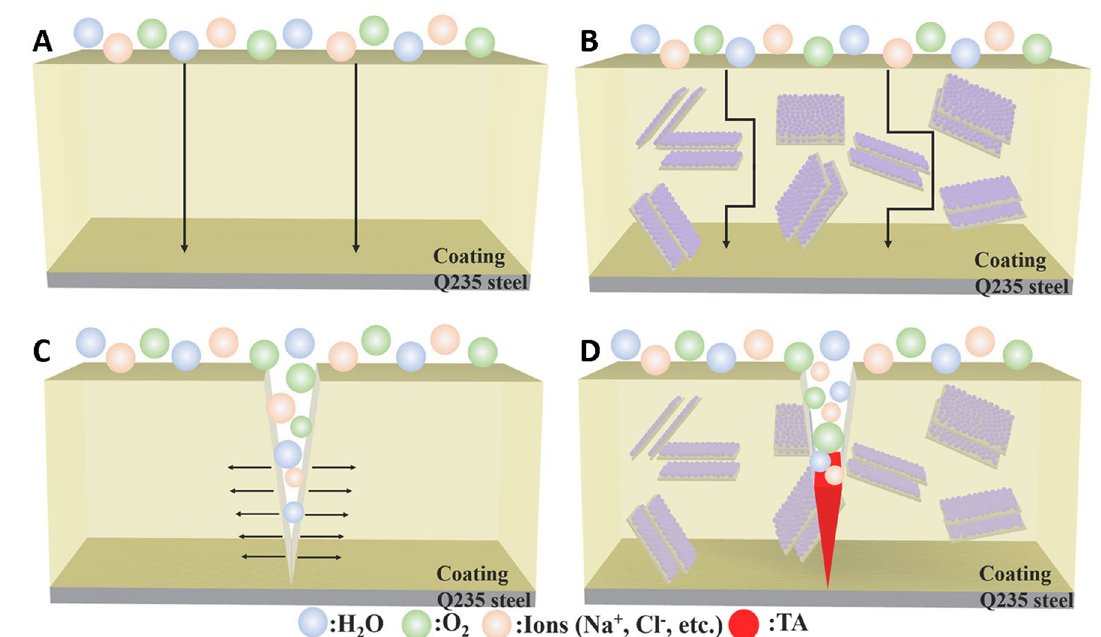
Fig. 4 The anticorrosion and self-healing mechanism of tannic acid (TA)@MXene-SiO 2 -contained epoxy coating: the corrosion process with- out ( A) and with B designed coating. C The process of crack propagation in the pure epoxy coating. D The epoxy/TA@MXene-SiO 2 coating and its self-healing property; MXenes could successfully form a layer-by-layer matrix structure in this coating, providing excellent corrosion protec- tion. Reproduced with permission from Ref. [62]. Copyright 2022